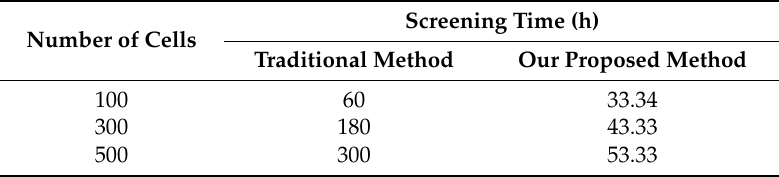
Table 5. Comparison of the screening